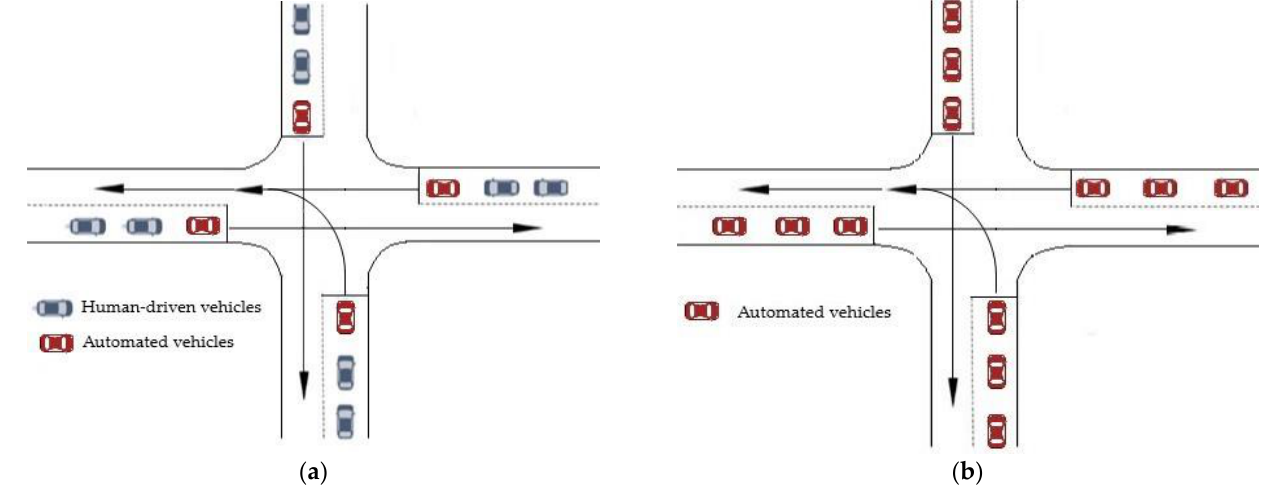
Figure 4. The leading automated vehicle experiments in the context of a non-signalized intersection: ( a ) mixed-traffic conditions with market penetration rates ranging from 20% to 80%; ( b ) fully autonomous conditions with a 100% market penetration rate.